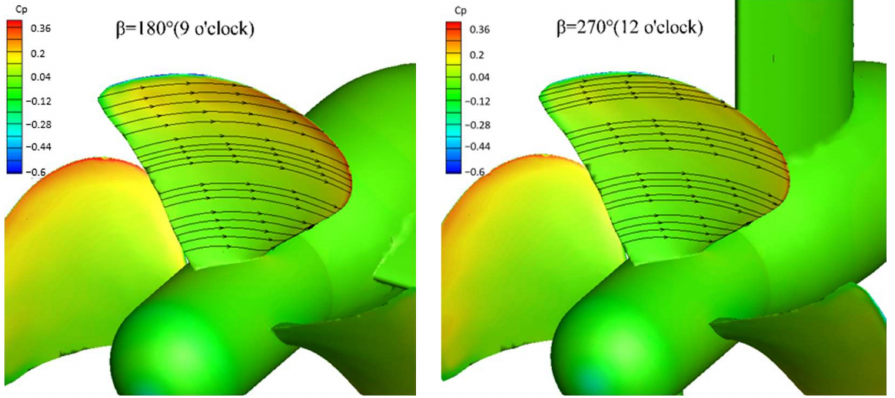
Figure 18. Flowline on blade surface ( J = 0.2).